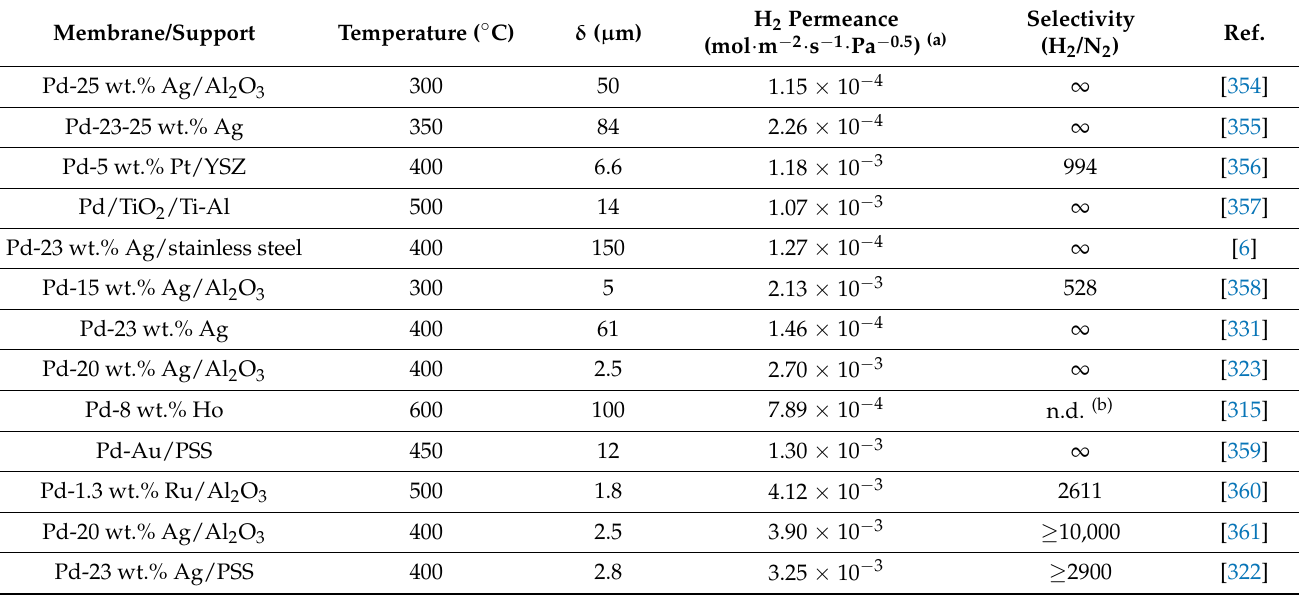
Table 7. Summary of Pd-based membranes’ performances and respective characteristics (H 2 diffusion through the membrane controls the permeation process).